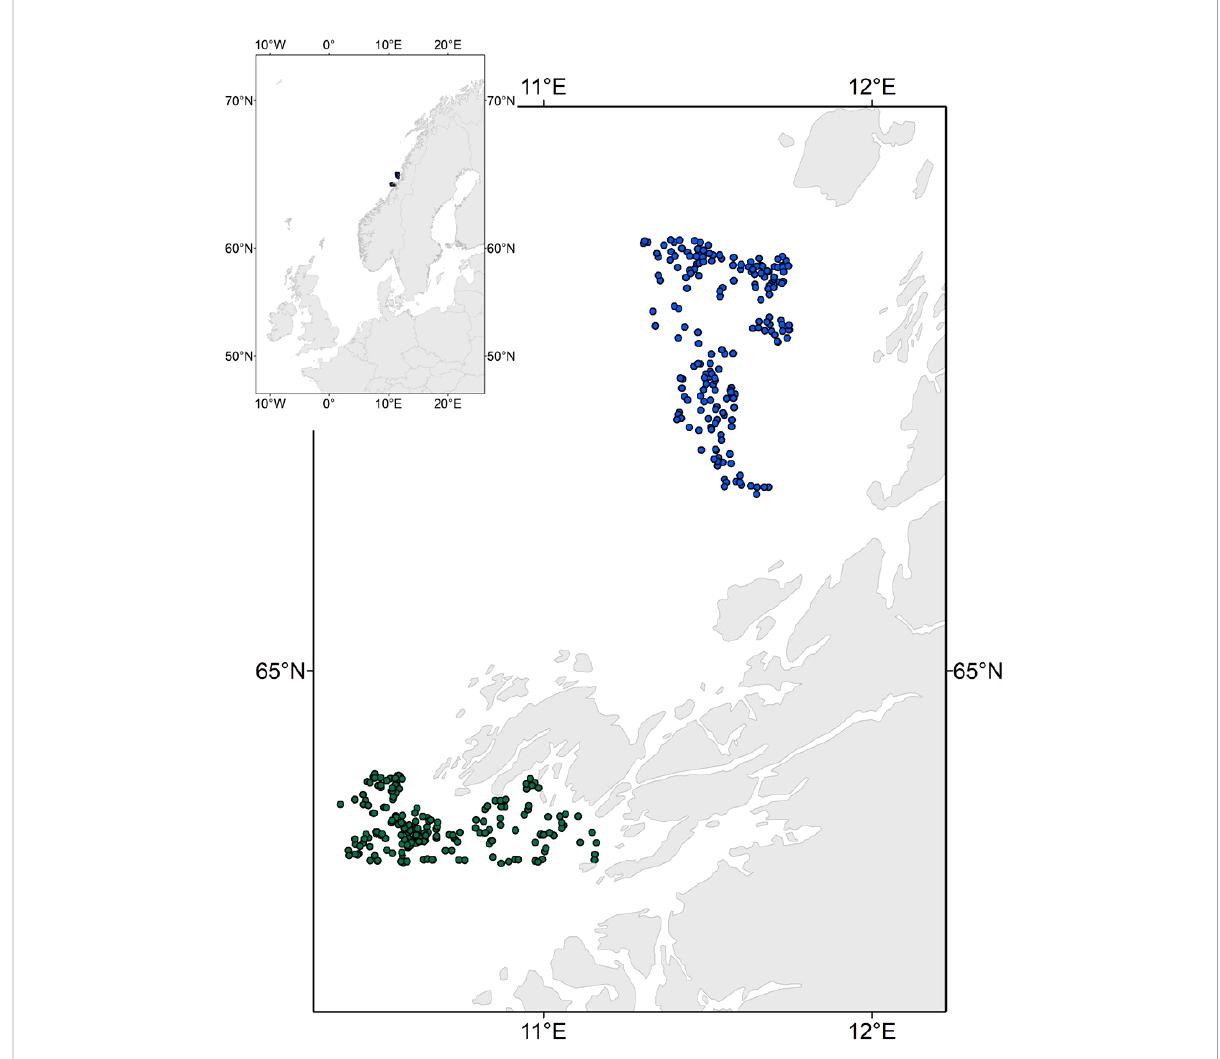
FIGURE 1 The study area on the northwest coast of Norway (as black dots in the small map). Stations at Vikna in the south (in dark green) and Helgeland to the north (in dark